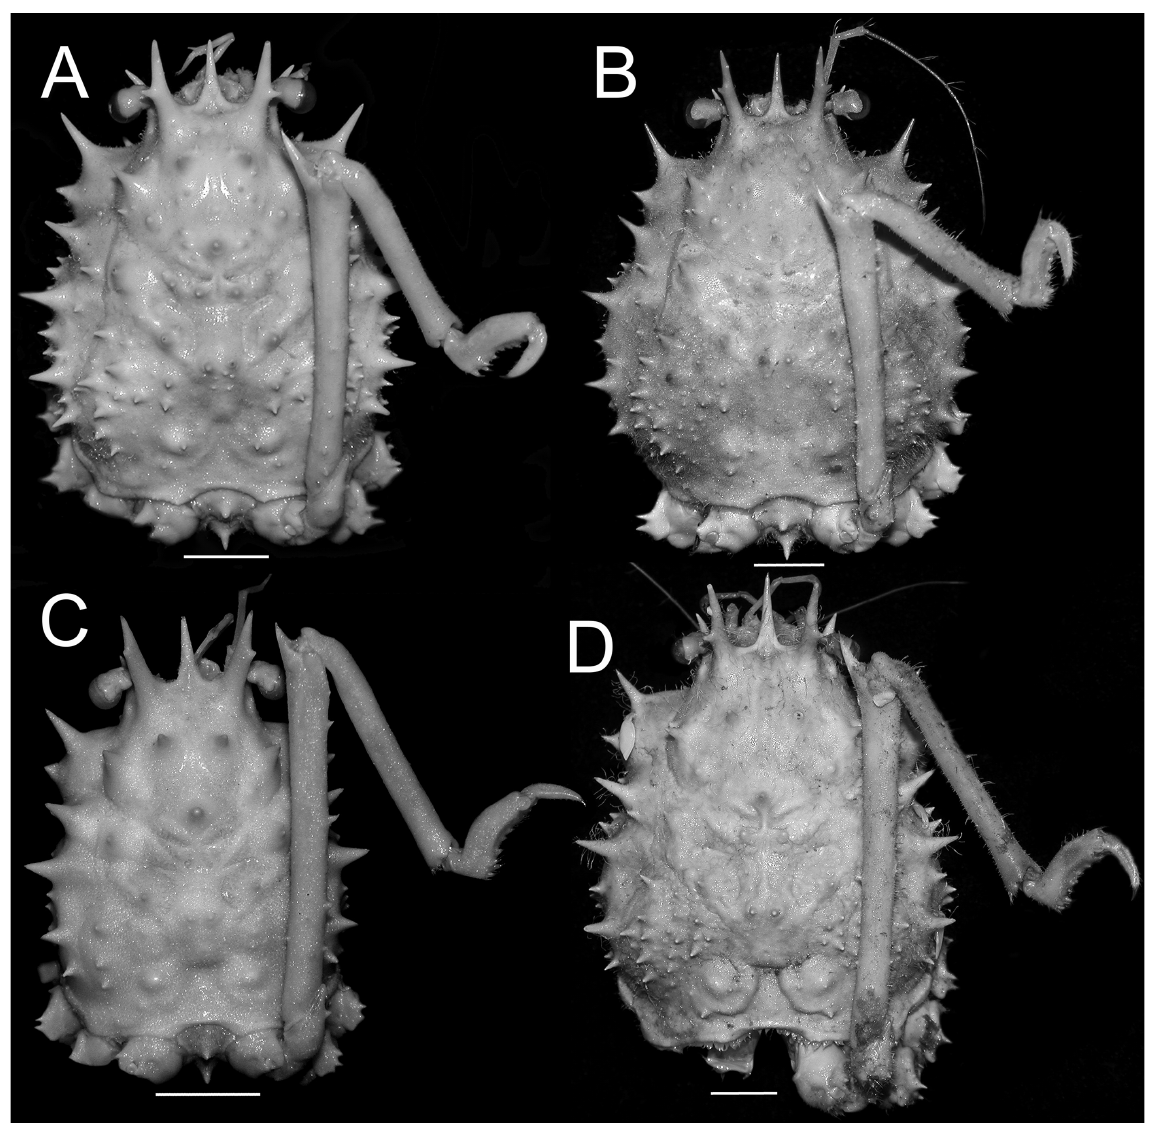
Fig. 14. Dorsal view of carapace showing position of folded right P5. A . Moloha grandperrini Guinot & Richer de Forges, 1995. Holotype, ♂ (cl 46.5 mm, cw 39.0 mm) (NHM 1948.9.7.27),